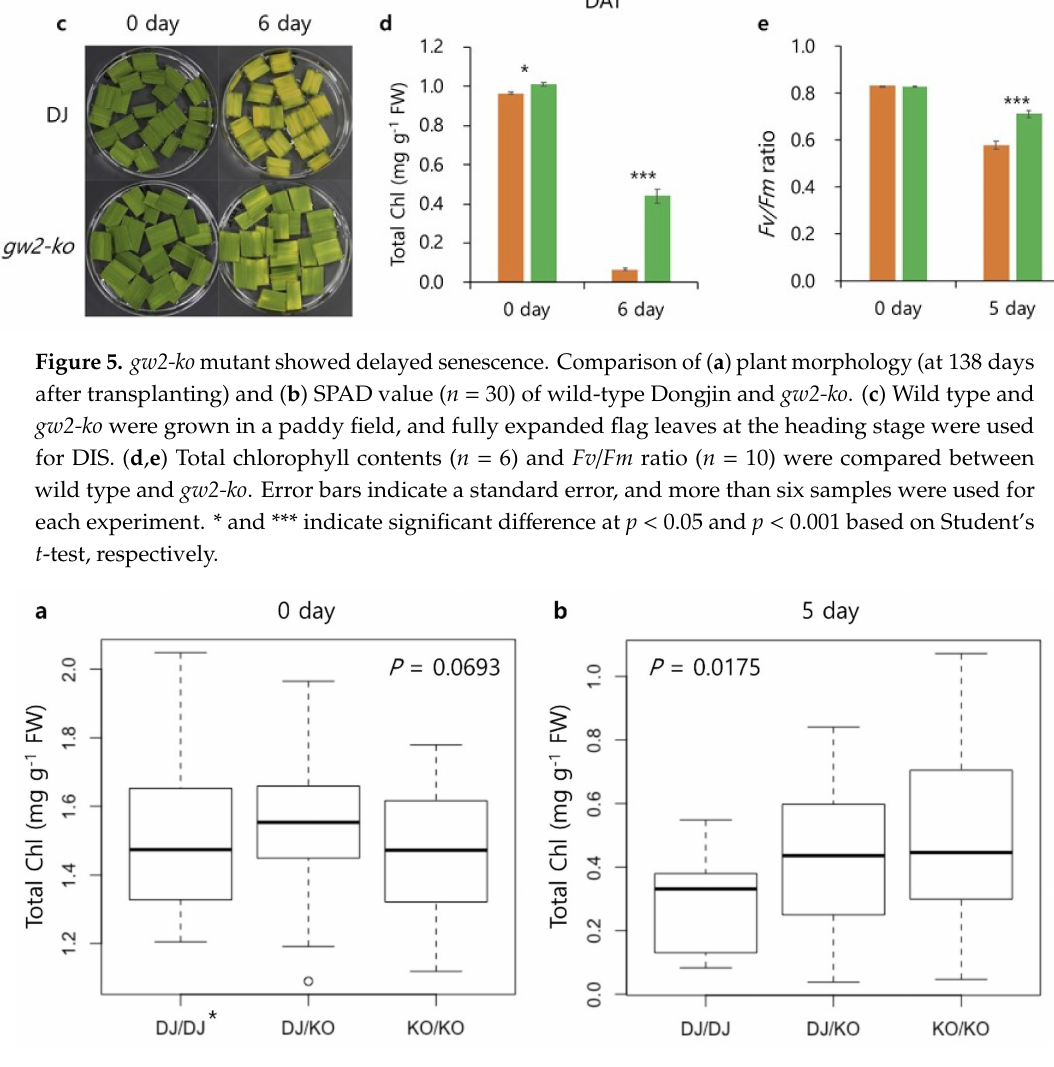
Figure 6. Boxplot of chlorophyll contents at ( a ) 0 day after incubation and ( b ) 5 days after incubation underthedark-inducedsenescenceconditionsintheF 2 populationderivedfromacrossbetweenDongjin and gw2-ko . Genotype was determined with two sets of primers, as indicated in Figure 4a—LP + RP and RB + RP. One-way ANOVA was conducted to determine the significant di ff erence between genotypes. *DJ / DJ: homozygous for Dongjin, DJ / KO: heterozygous, KO / KO: homozygous for gw2-ko